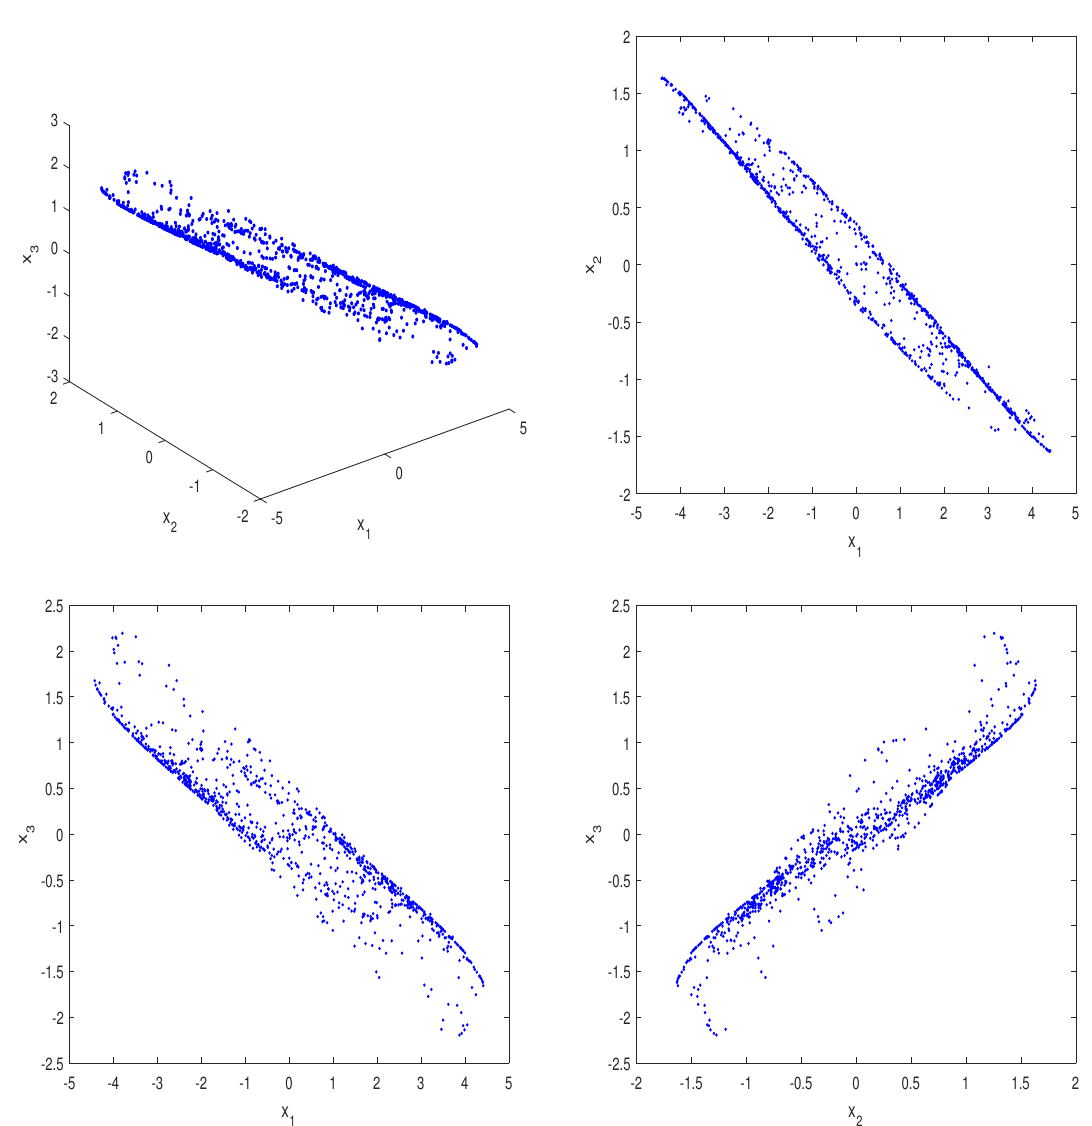
Figure 2. Phase-plot portraits of the D.T.H.N.N with incommensurate fractional variable-order